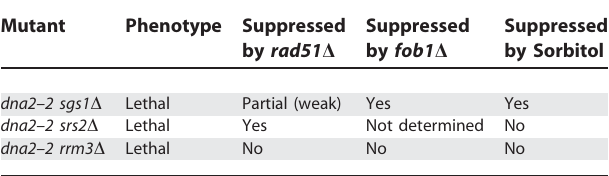
Table 2. Genetic Interactions of DNA2 with Other Helicases